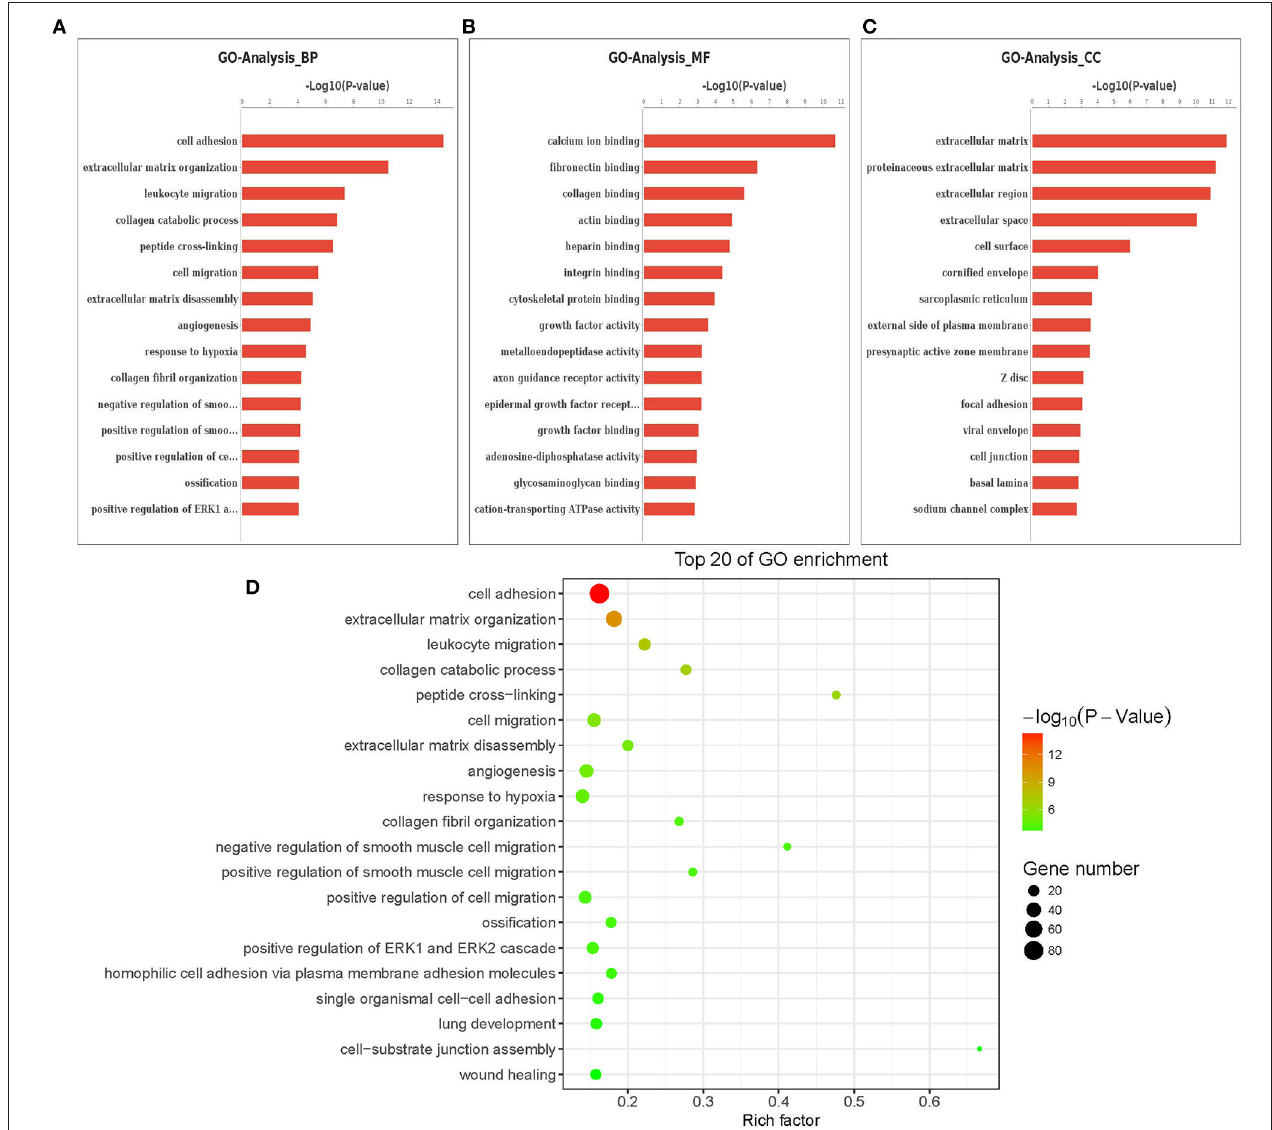
FIGURE 4 | Enriched GO terms of DGEs in ACADSB − / − bMECs. (A) The most significant differences in biological processes. (B) The most significant differences in cellular components. (C) The most significant differences in molecular functions. (D) The top 20 GO terms. GO, Gene Ontology. BP, biological process. CC, cellular component. MF, molecular function. DEG, differentially expressed